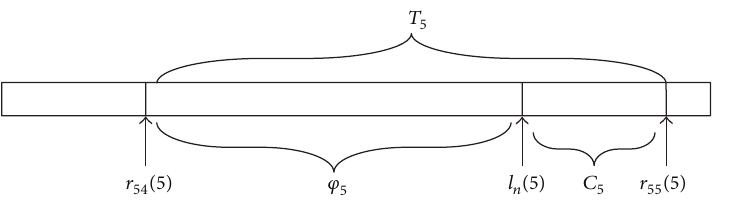
Figure 12: Problem area 𝜑 5 , for nonpreemptive uniprocessor scheduling.